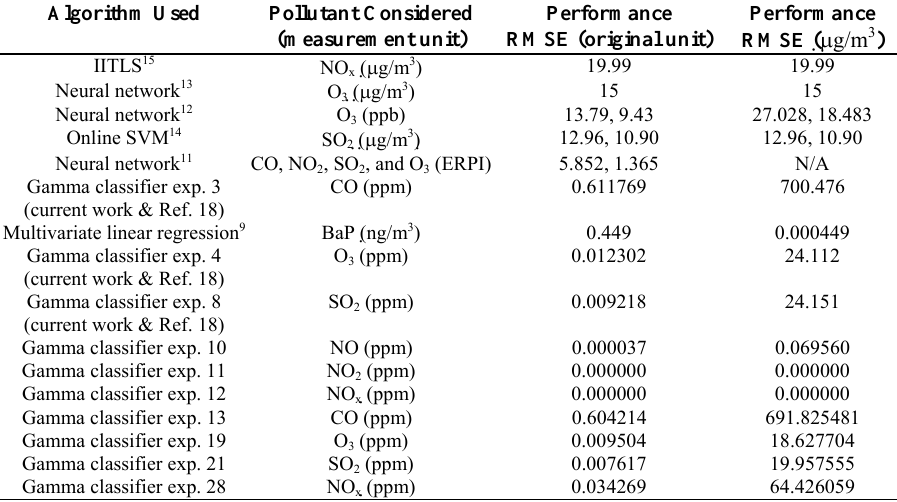
Table 10. Comparison of related results (diverse databases) in RMSE; exp. means “experiment”. Algorithm